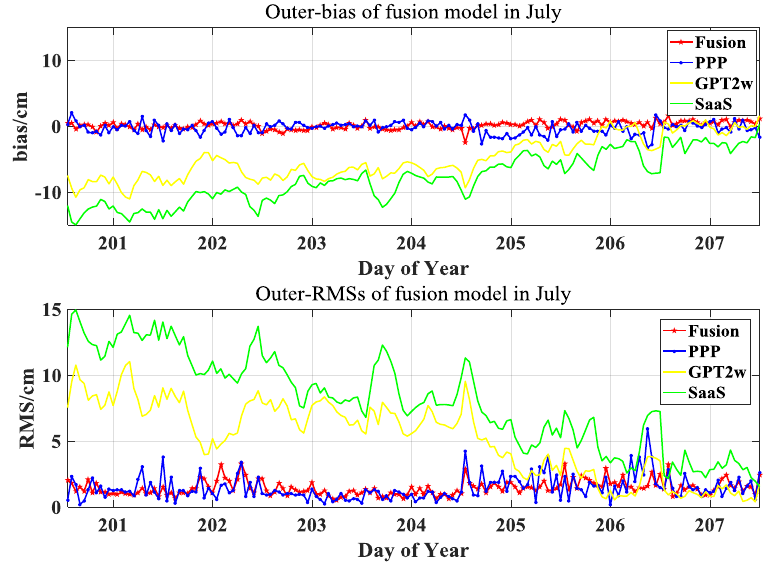
Figure 5. Bias and RMS of each troposphere model in July.